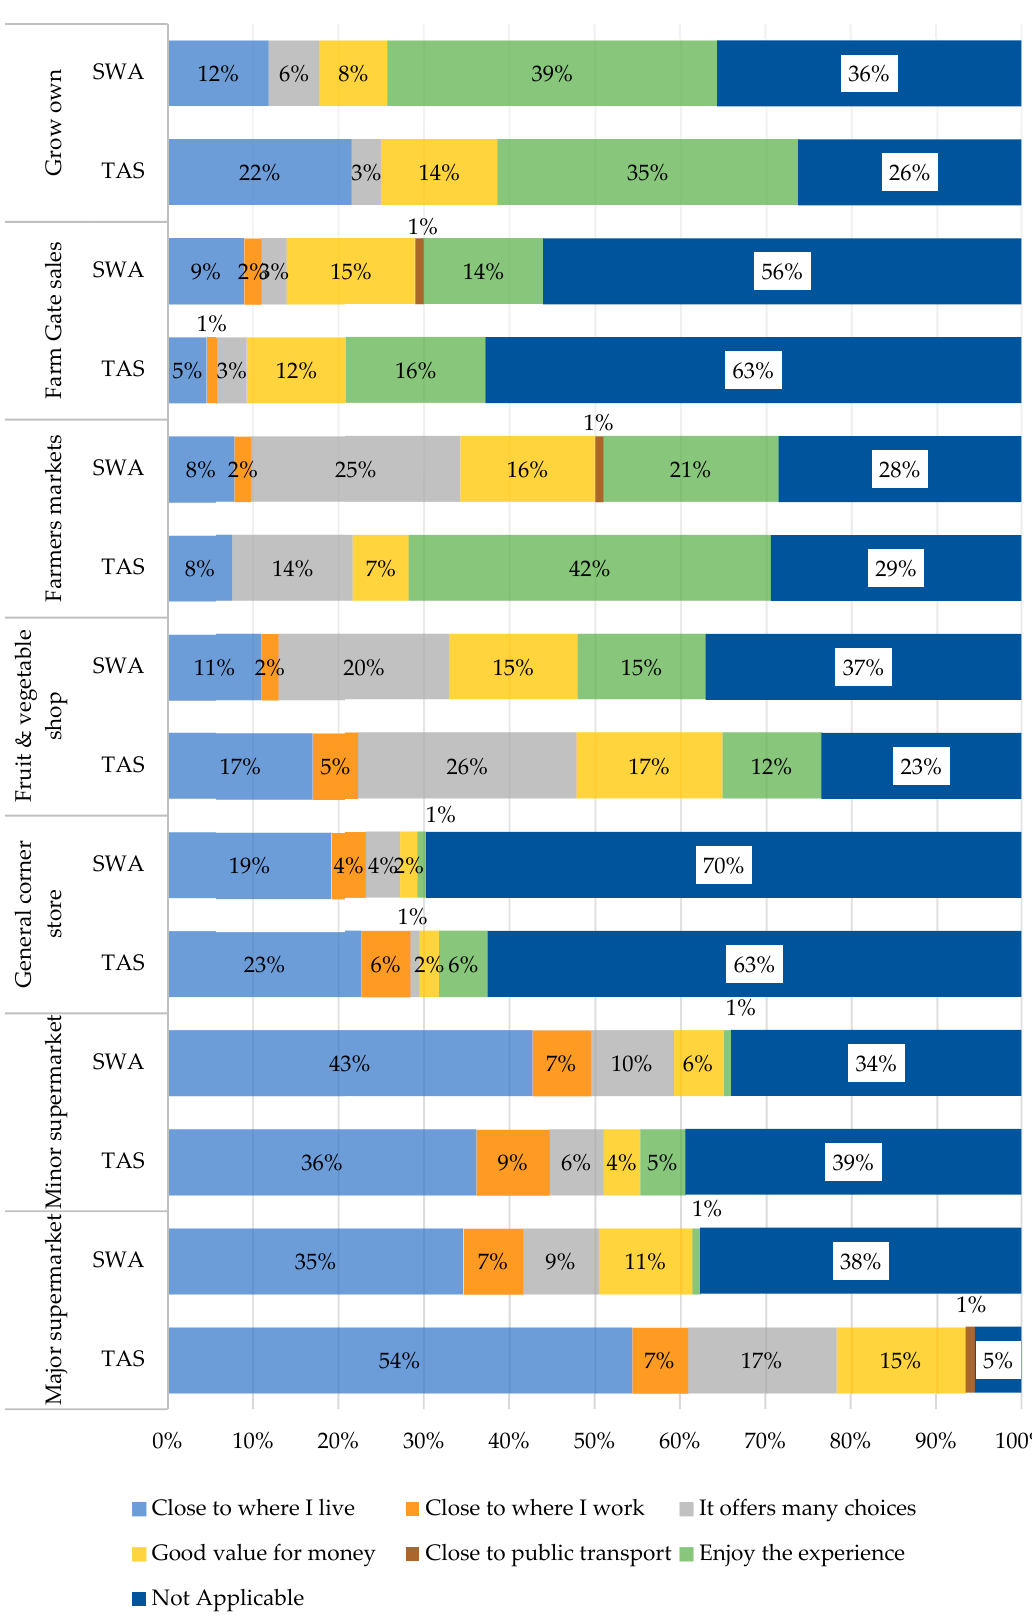
Figure 4. Motivating reasons for purchasing regionally grown foods from each shopping outlet in (a) Tasmania (TAS) and (b) South Western Australia (SWA).